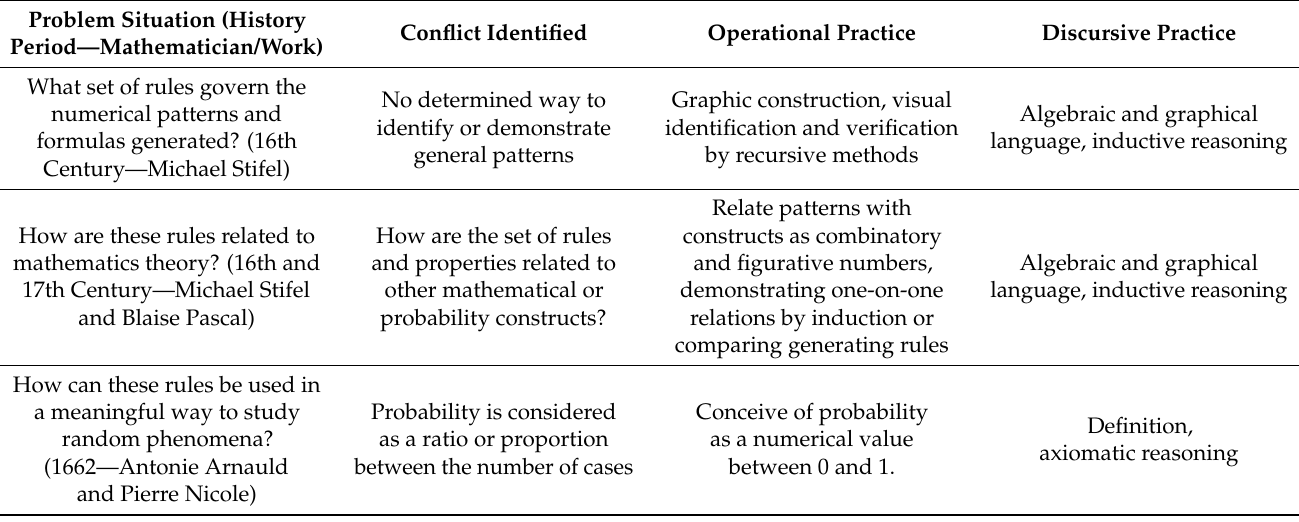
Table 3. Historical problem situations (15th century–16th century).